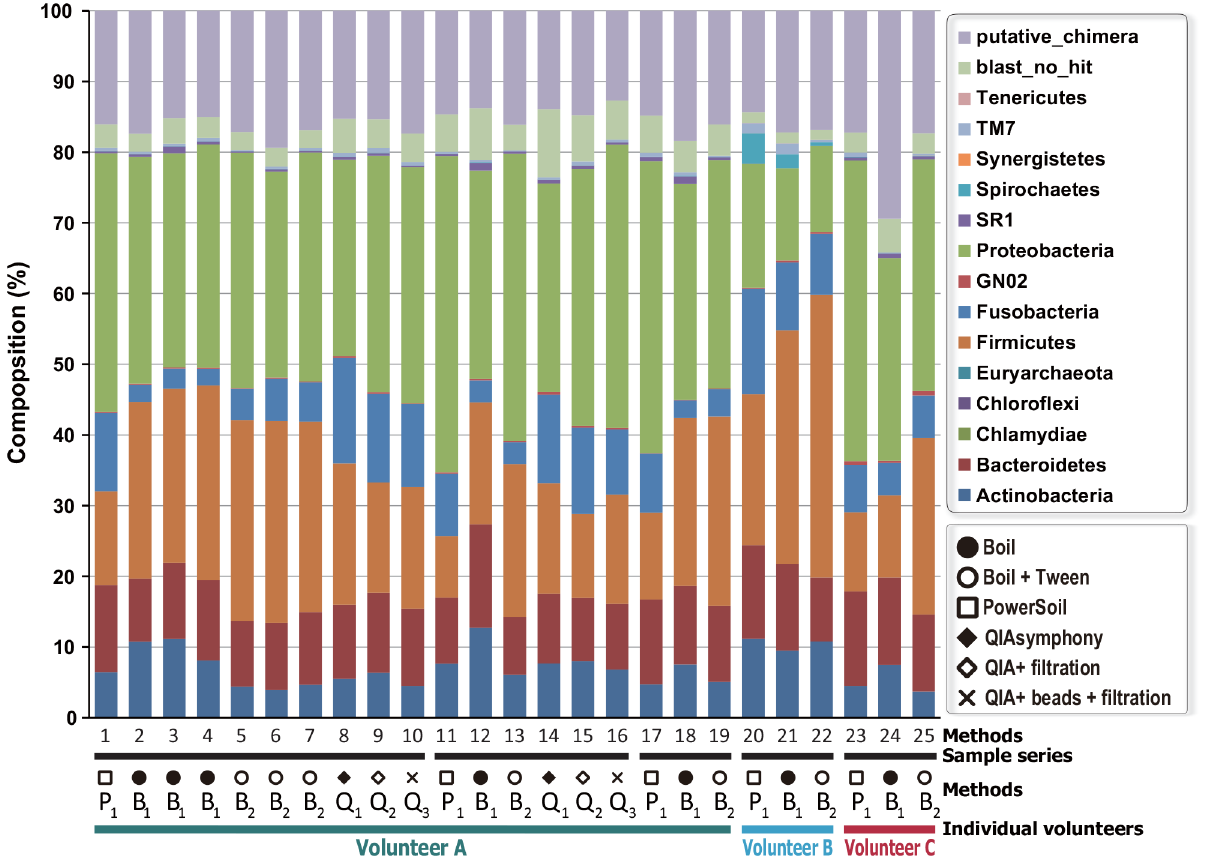
Fig 1. Distribution of microbes at the phylum level found in each of the 25 samples. Detailed information for the sample number is shown in Table 1. P1, B1, B2, Q1, Q2, and Q3 represent PowerSoil, boiling, boiling with tween, QIAsymphony, QIAsymphony with filtration, and QIAsymphony with beads beating and filtration,